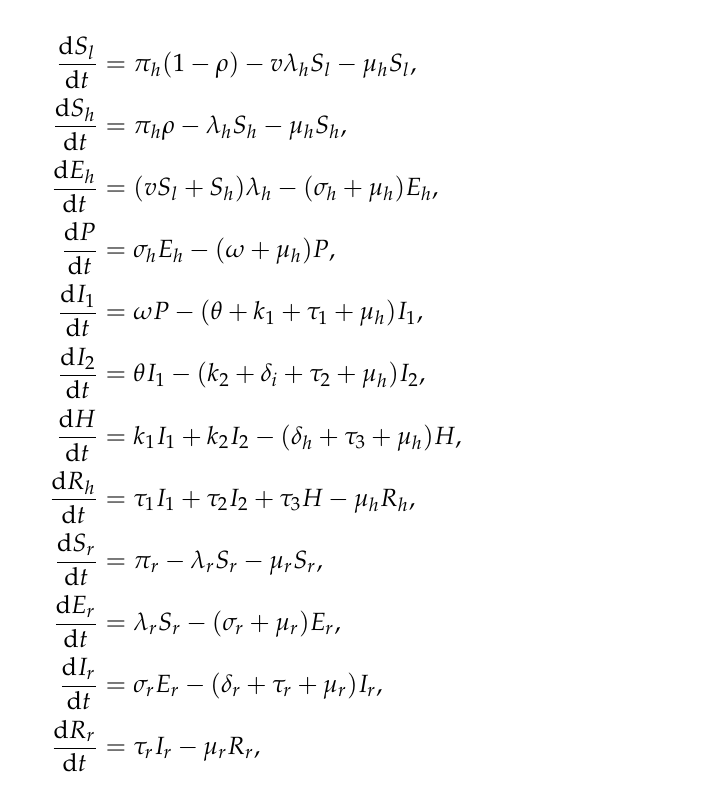
Table 1. Enunciation of variables and parameters of governing system (1)